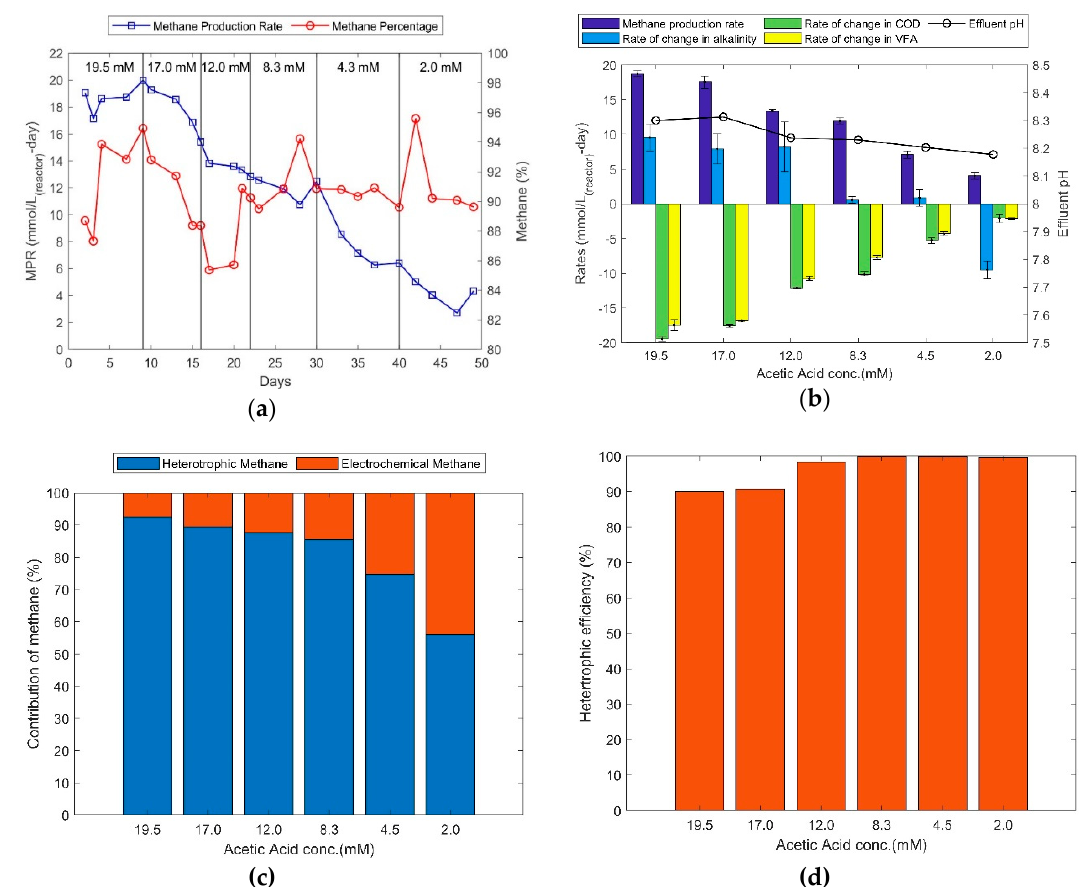
Figure 4: ( a ) Methane production rate (blue) and biogas methane percentage (red) at decreasing feed concentrations of acetic acid. ( b ) pH, methane production and rates of change in COD, VFA and alkalinity at tested acetic acid feed concentrations. ( c ) Methane source distribution between heterotrophic (blue) and electrochemical (red) methane. ( d ) Heterotrophic efficiency to methane considering 100% electrochemical efficiency.